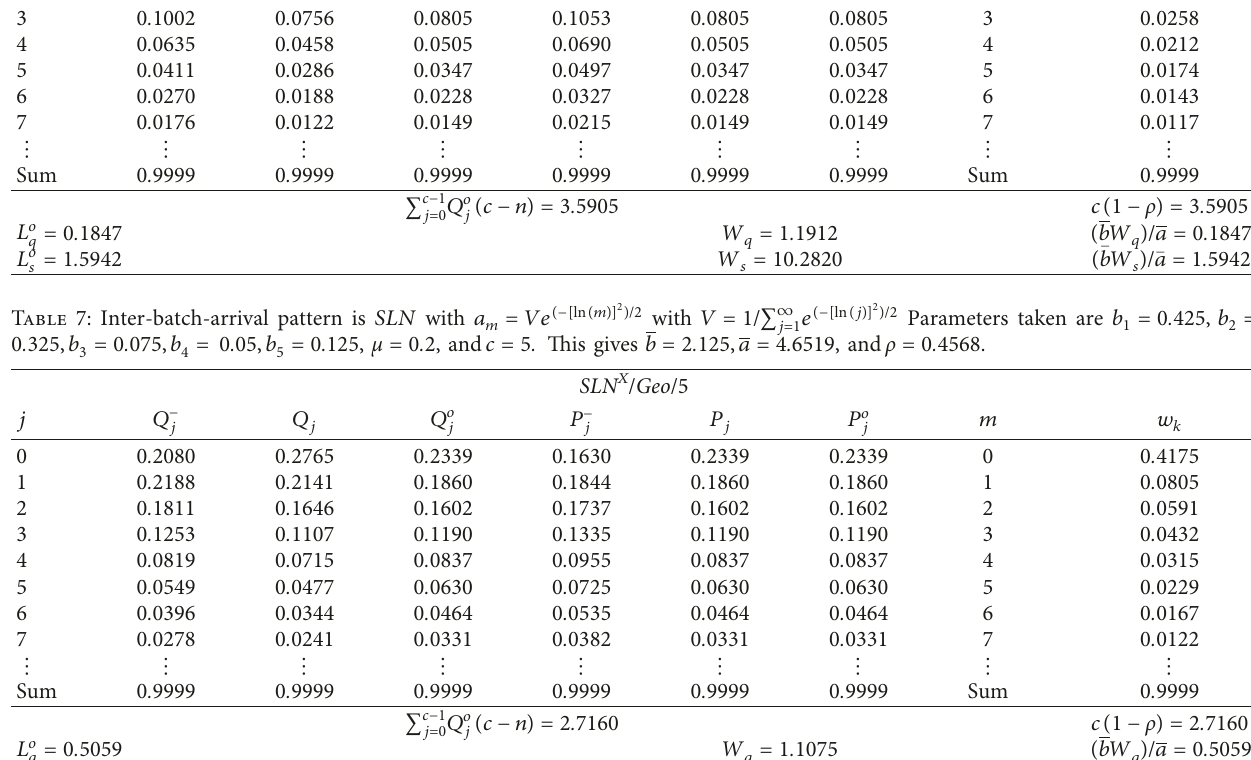
� √ j M − . Parameters taken are M � 2 ,b 0